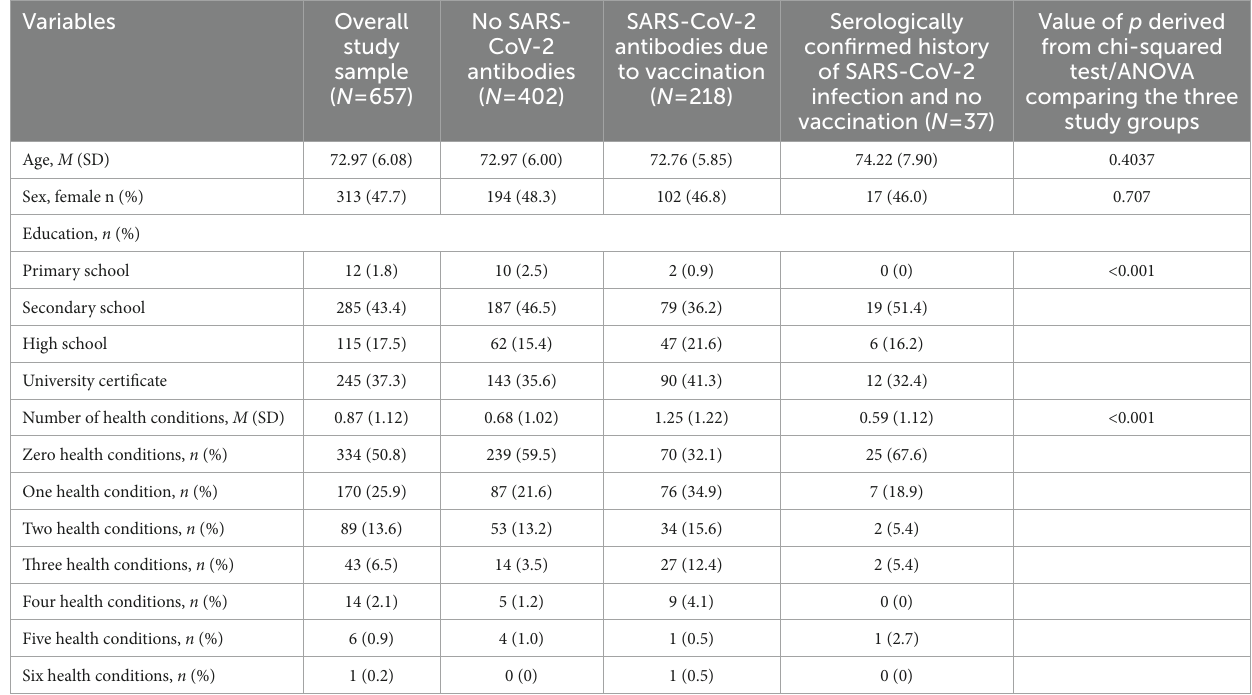
TABLE 1 Descriptive statistics for sociodemographic variables and health conditions for the overall study sample and across subgroups based on presence of COVID-19